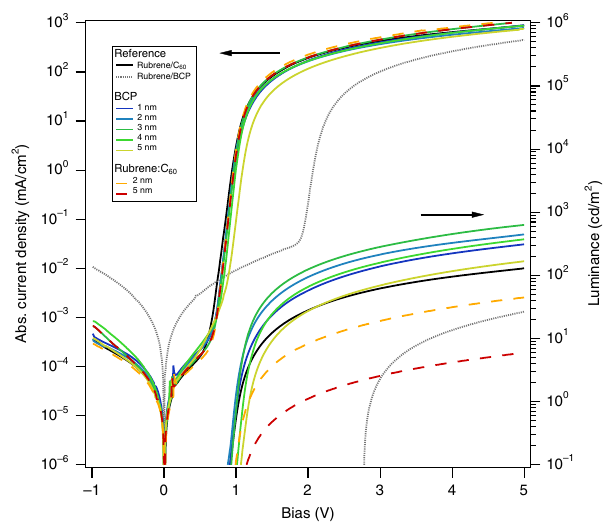
Fig. 2 OLED device characteristic. J ( V )- and L ( V )-characteristics of rubrene/C 60 OLEDs with BCP or rubrene:C60 (1:1) interlayers inserted between the rubrene and C 60 layers. A plot on linear scale can be found